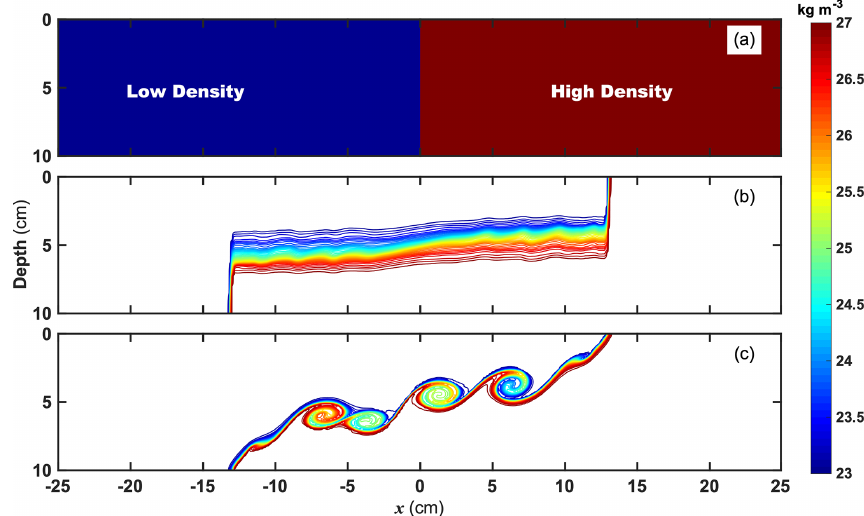
Figure 1. (a) The initial density σ (hereafter the same expression) field of the lock-exchange case and contour plots of density at t = 4 . 5s, where the contour interval is 0.1kgm − 3 under the hydrostatic (a) and nonhydrostatic (b) model